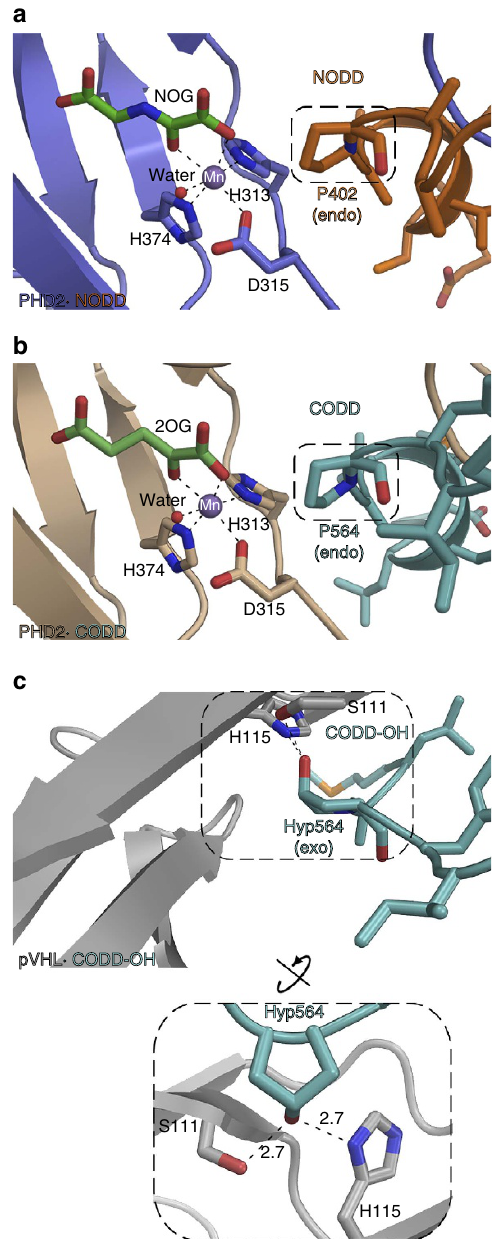
Figure 3 | PHD active-site chemistry. Binding of proline (NODD/CODD) to PHD2 and hydroxyproline/Hyp (CODD-OH) to the VHL component of the VCB complex. ( a , b ) Conserved binding modes of the Pro402 NODD / Pro564 CODD to PHD2 (PDB: 5L9V and 5L9B). It is noteworthy that the proline C4-methylene adopts the endo -conformation when bound to PHD2 in both the NODD and CODD complex structures. ( c ) In contrast, Hyp564 CODD-OH adopts the exo - conformation when bound to the VCB complex (PDB: 1LM8) 32–34 . Binding of O 2 is proposed to be limiting in PHD-ODD catalysis 57,58 . It is noteworthy that the metal bound water, which is replaced by O 2 in catalysis, is similarly positioned in both the NODD and CODD complexes (with NOG/Mn substituted for